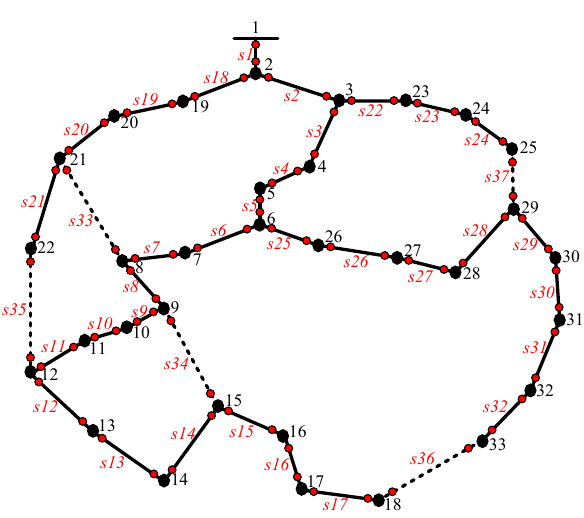
Figure 2. The single-line diagram of IEEE 33-bus network.